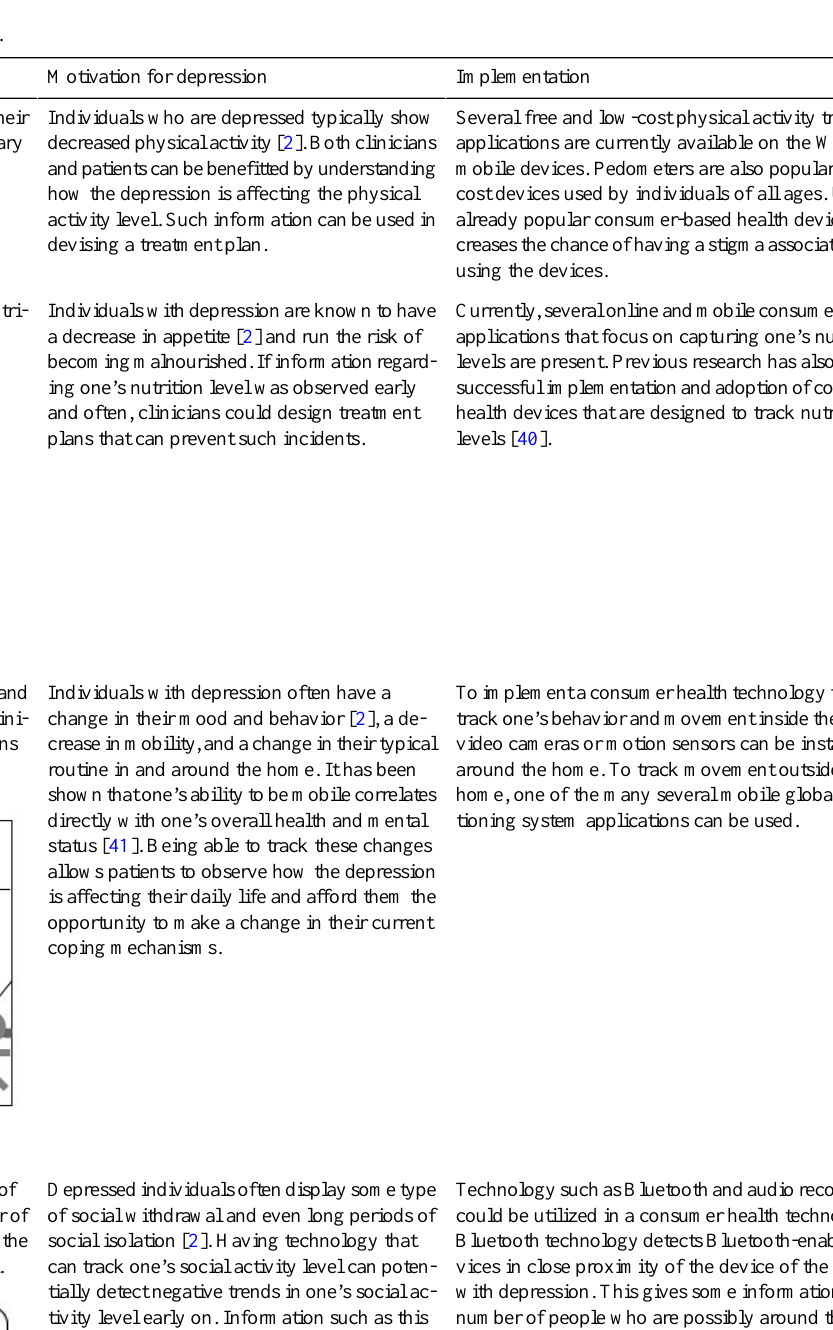
Table 1. Overview of technology concepts.